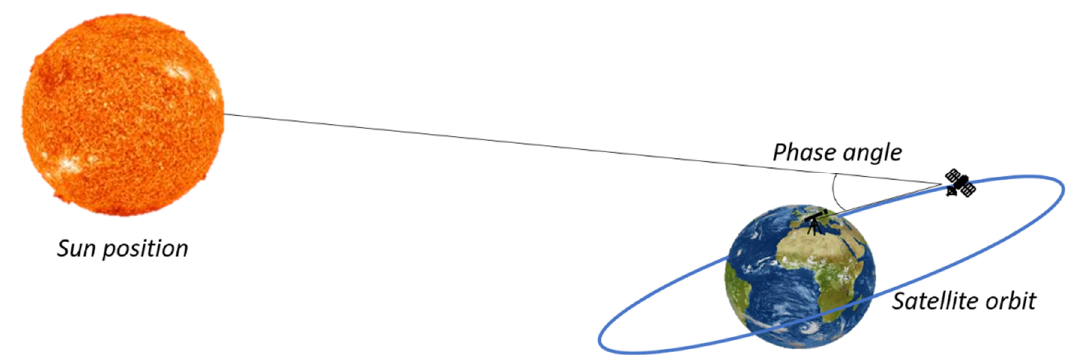
Figure 15. Phase angle—this image shows the phase angle, observer–object–sun, needed to compute the amount of light reflected by the object.